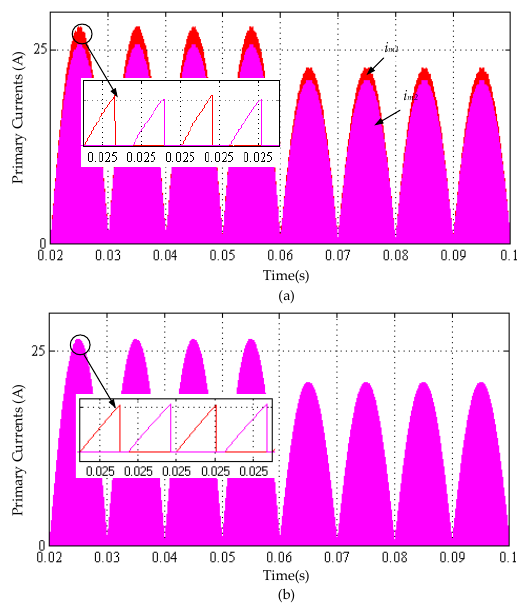
Figure 11. Waveforms for primary currents by two current sharing controllers: ( a ) PI current sharing control; ( b ) sliding mode current sharing control. Energies 2018 , 11 , x FOR PEER REVIEW 13 of 20